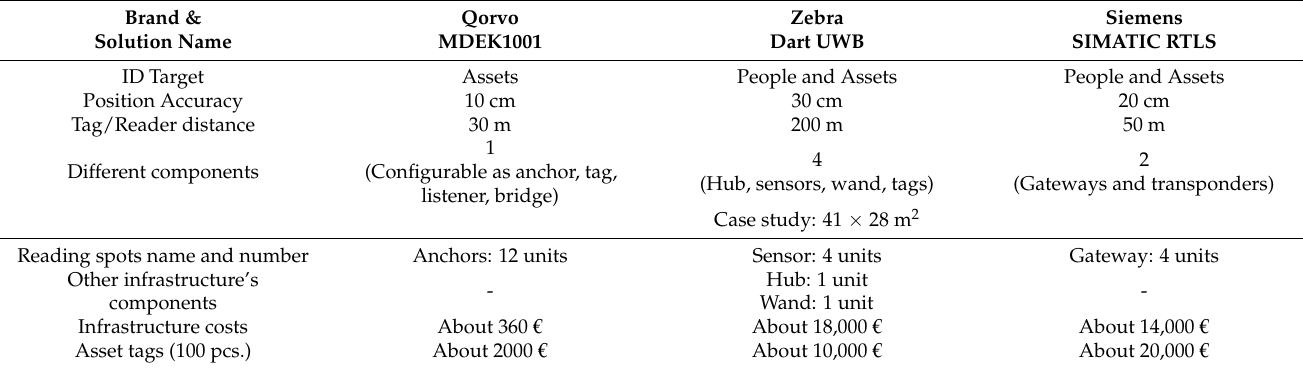
Table 11. Economic comparison, considering the whole warehouse